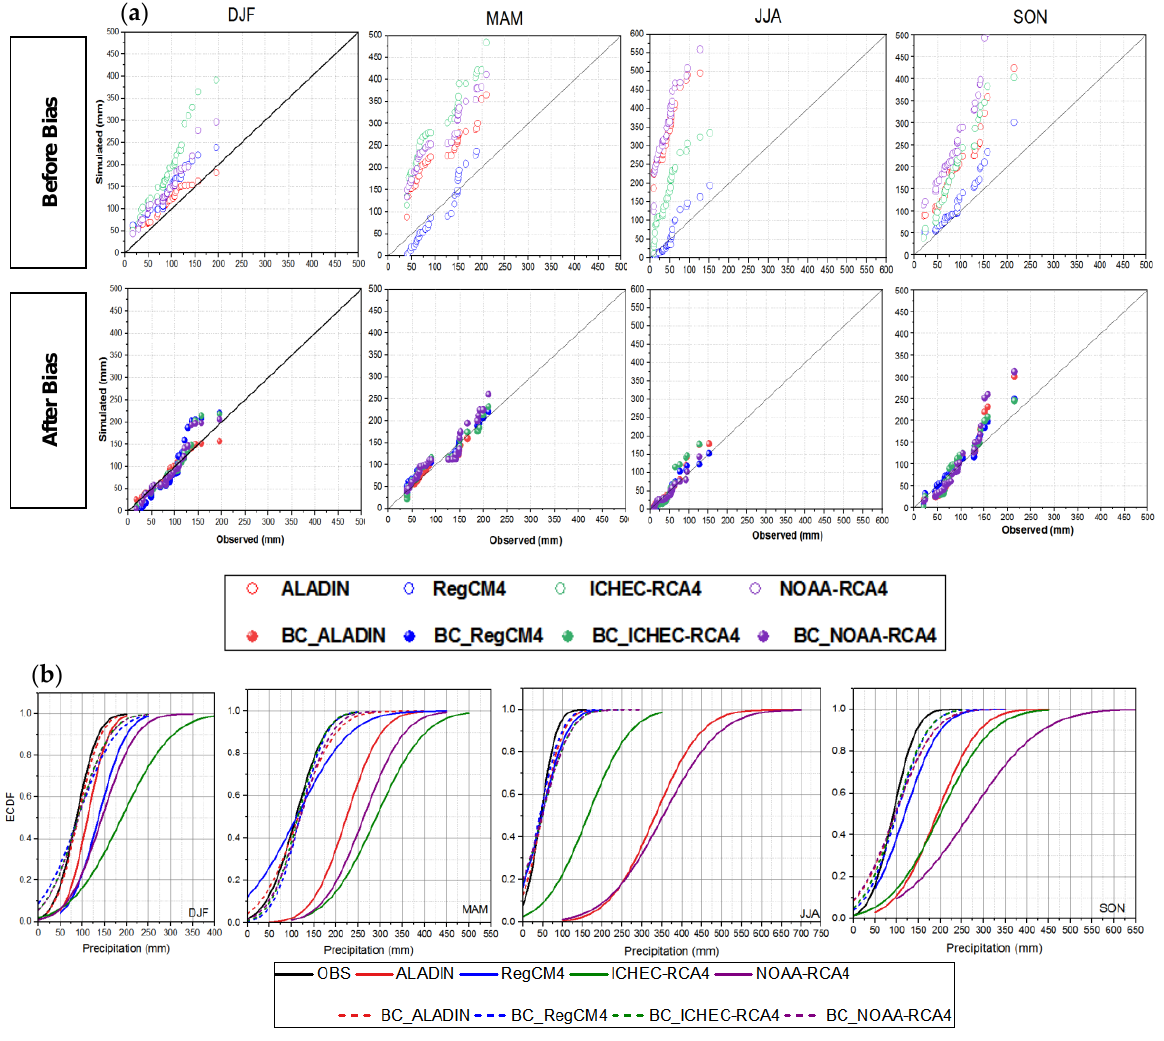
Figure 5. Areal-averaged seasonal (DJF, MAM, JJA, SON) precipitation for observed, raw, and adjusted (BC) RCMs for the period (1970 – 2005). ( a ) The Q-Q plot; ( b ) ECDF distribution.